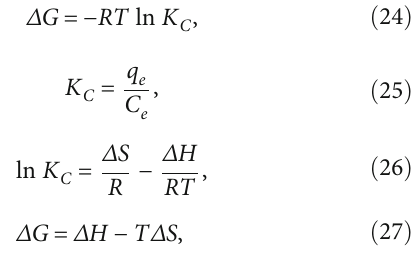
X vs. temperature (K) for sorption of